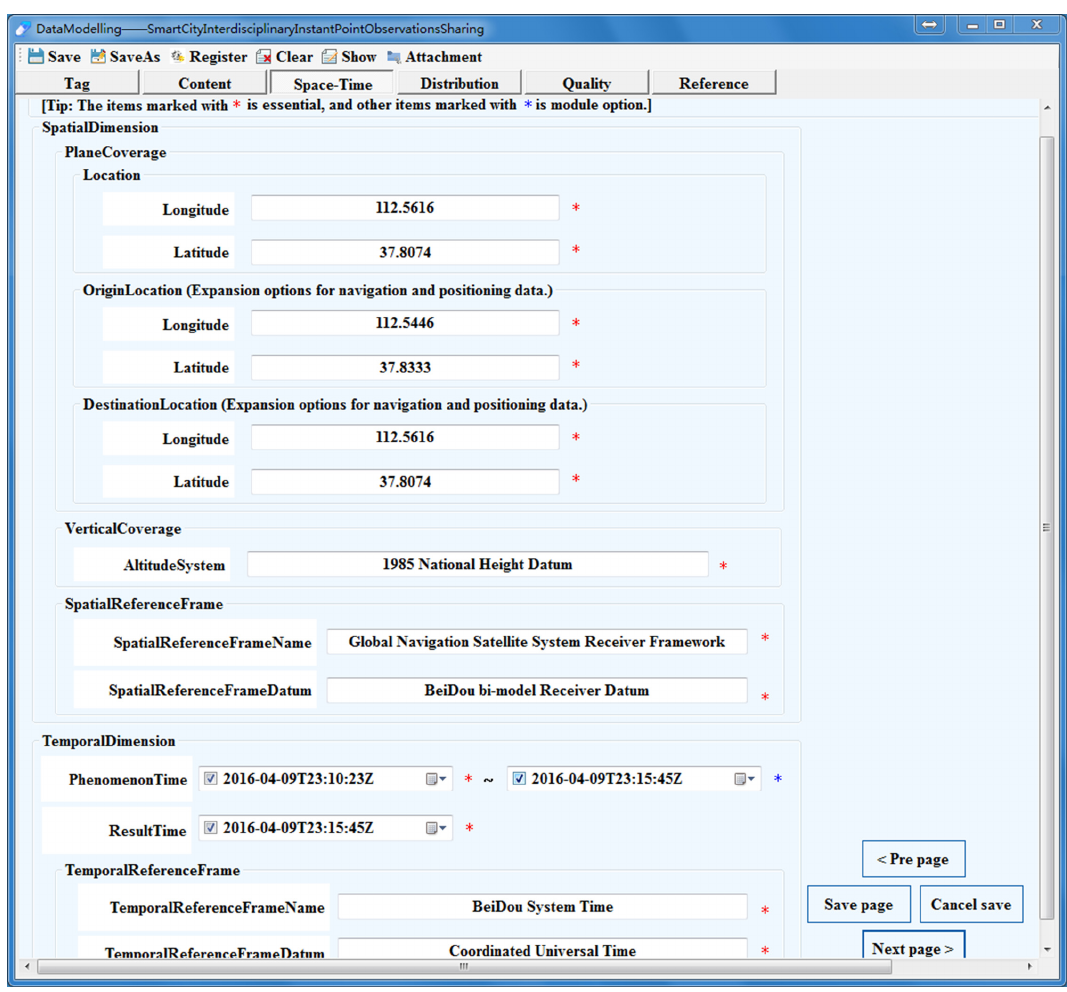
Figure 8. The modeling guide for the point observation data: Space-Time information modeling. For the DMM, the items marked with the red asterisks are essential, and the other items marked with the blue asterisks are optional.